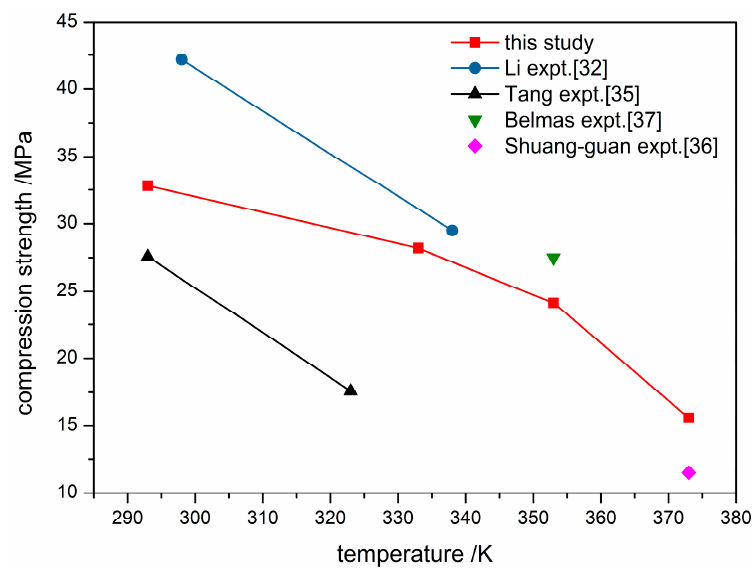
Figure 4. Compression strength curve of PBX at different temperatures, also shown are experimental results from references [32,35–37].